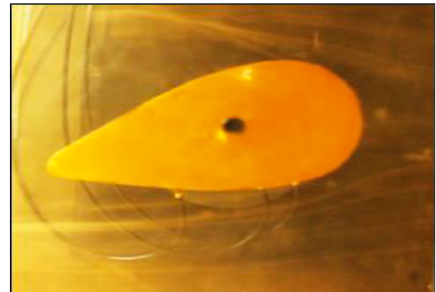
Figure 28: Smoke flow visualization at 15 ° AOA for the 1st module